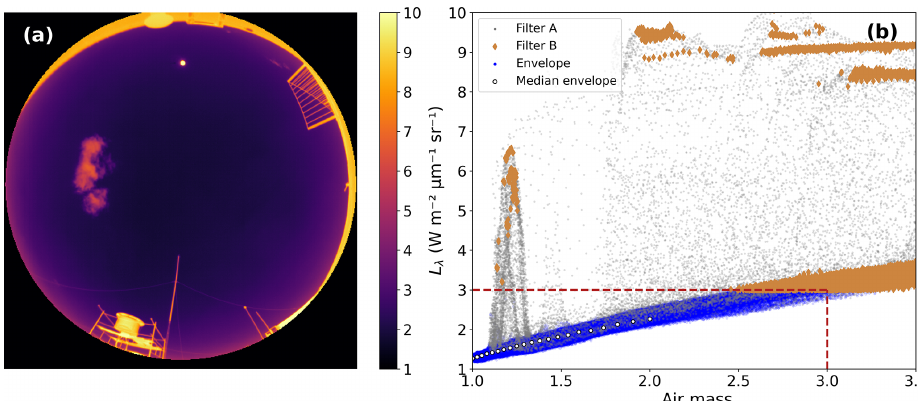
Figure 1. Spectral radiance ( L λ ) measured at ASIVA’s channel 4 (i.e., 10–12µm) on 6 July 2017 at 15:17UTC (12:17LT) in São Paulo: ( a ) calibrated radiance image; ( b ) L λ plotted as a function of the air mass. Cloudy and physical structure pixels were eliminated by applying the procedure described in the text (Filters A and B). Envelope data points correspond to clear-sky L λ , from which medians were computed at specific air mass